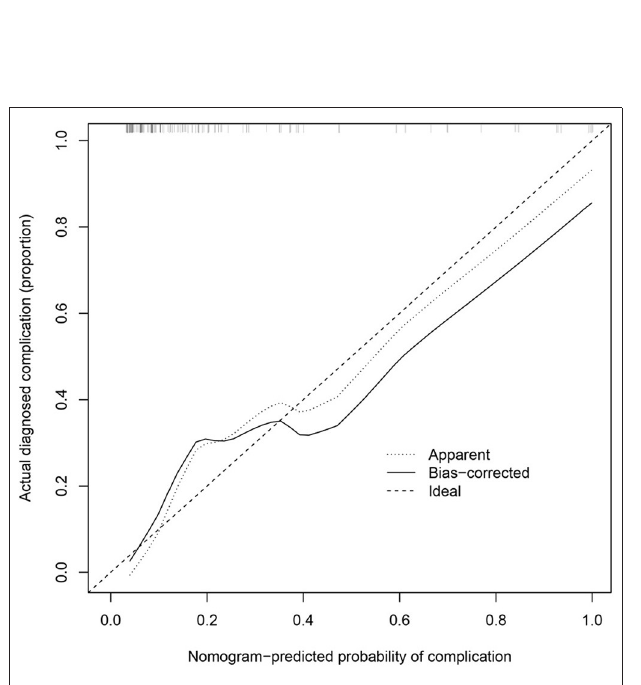
FIGURE 3 | Calibration curves of the nomogram prediction in the cohort. The x-axis represents the predicted postoperative complication risk. The y-axis represents the actual happened complication. The diagonal dotted line represents a perfect prediction by an ideal model. The solid line represents the performance of the nomogram, of which a closer fit to the diagonal dotted line represents a better prediction.